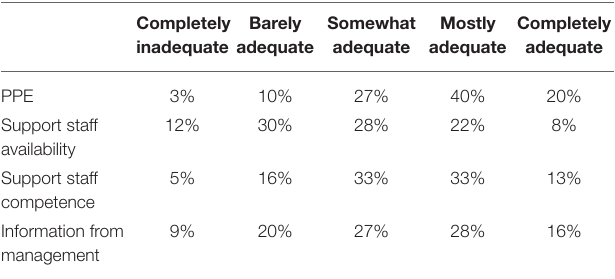
TABLE 3 | Veterinary technicians’ perceptions of the adequacy of resources they were provided during COVID-19.